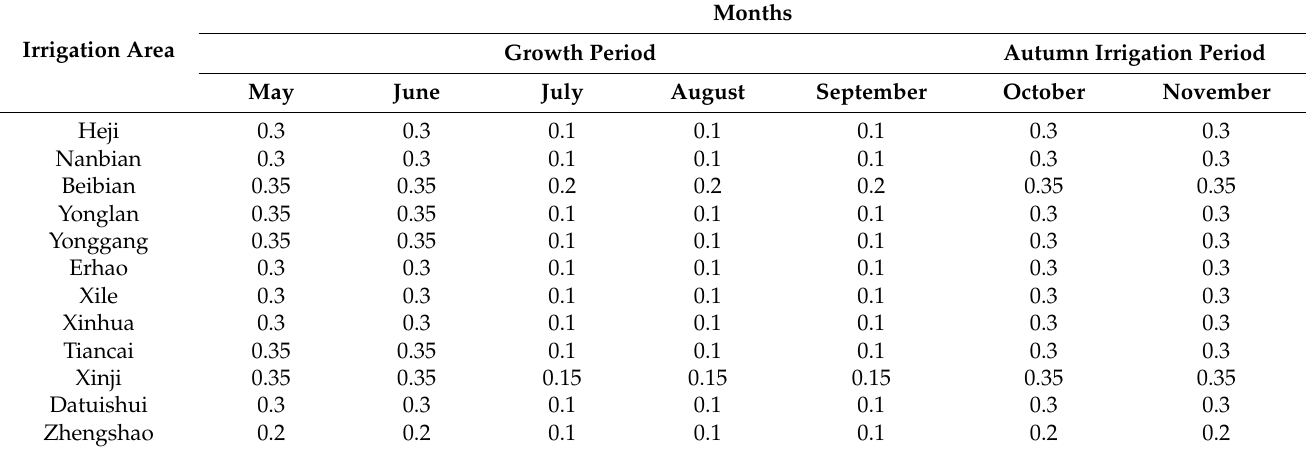
Table 3. Calibration results of recharge coefficient of irrigation water in different areas and different periods. Irrigation Area